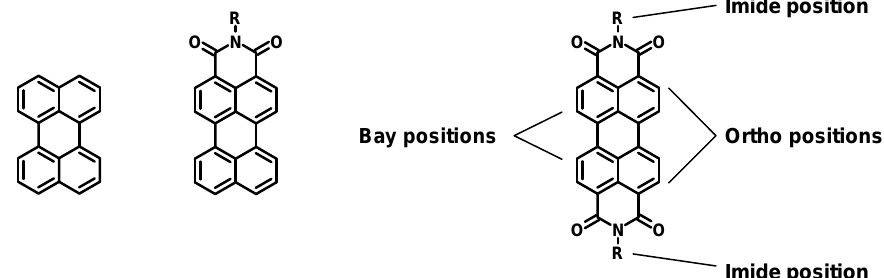
Figure 2. The following are shown from left to right: perylene, perylene monoimide (PMI), and perylene diimide (PDI) with the three functionalization positions.